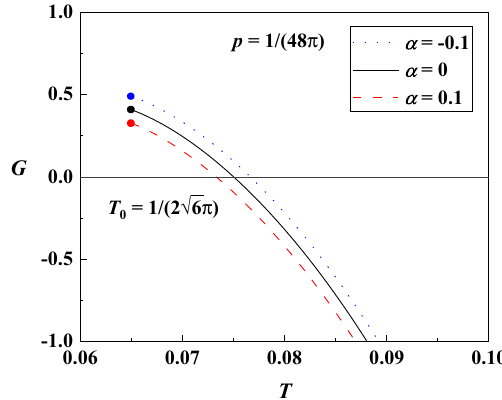
Fig. 6 The HP phase transition temperature of the RN–AdS black holes as a function of pressure, with different values of Φ . The HP phase transition can happen at all pressures, and T HP decreases with Φ at a fixed